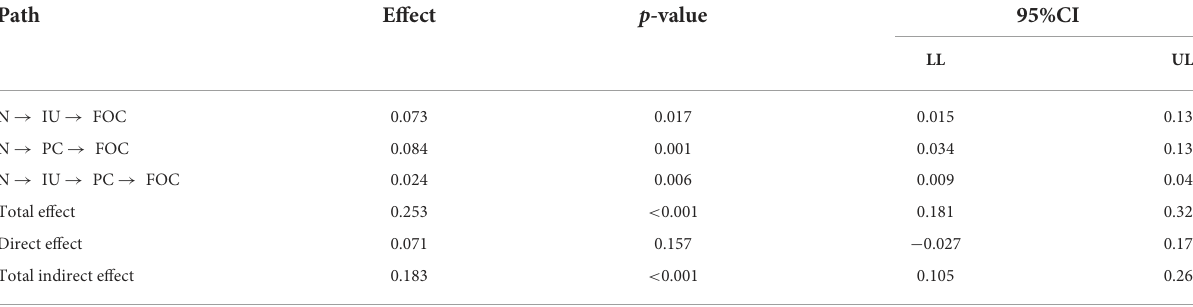
TABLE 3 Indirect effect of neuroticism on fear of COVID-19 via intolerance of uncertainty and perceived constraints.